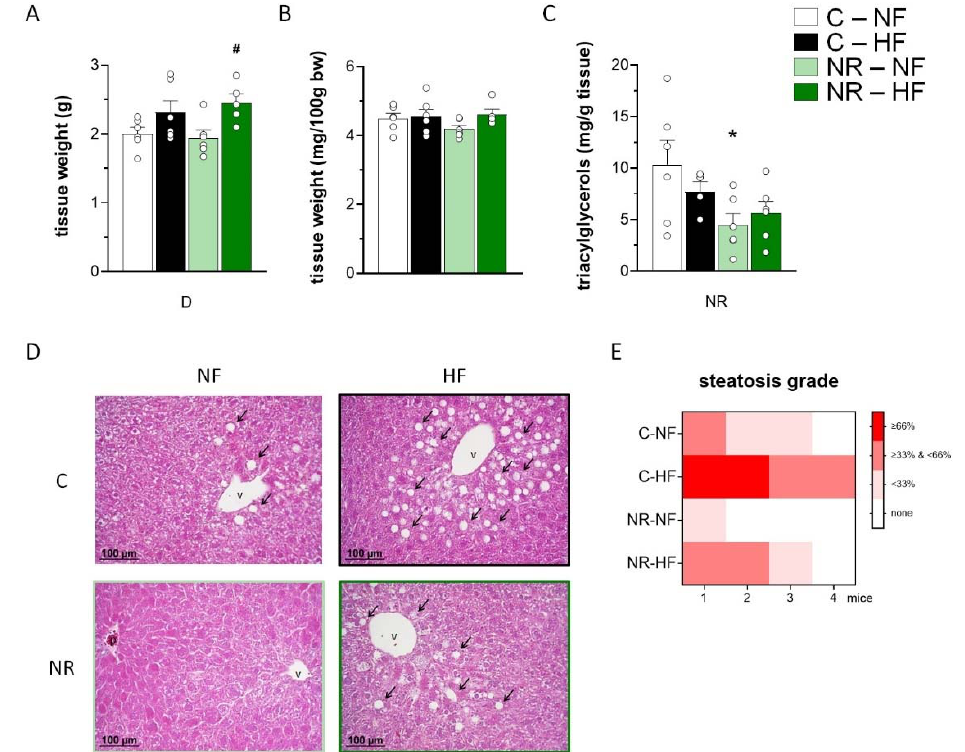
Figure 4. Early-life nicotinamide riboside (NR) treatment resulted in decreased liver triacylglycerol content in the liver in adulthood. Newborn male mice received NR or vehicle (water; control) from day 2 to 20 of age, were weaned onto a chow diet on day 21, and were assigned to either an HF or a normal-fat (NF) diet on day 90 for 10 weeks. Liver weight ( A ), weight as a percentage of body weight ( B ), and triacylglycerol content ( C ) at the end of the experiment. Data are the mean ± SEM of 5–6 animals per group. Circles correspond to individual data. Statistics ( p < 0.05): NR treatment, and D diet effect (two-way ANOVA); * NR vs. control, # HF vs. NF ( t -Student). Representative micrographs (magnification × 10) of H&E stained liver sections ( D ) and heat map of hepatic steatosis grade in liver biopsies from four mice ( E ) of each experimental group are shown. Symbol images: arrows denote macrovesicular steatosis, v indicates central vein, p indicates portal vein.